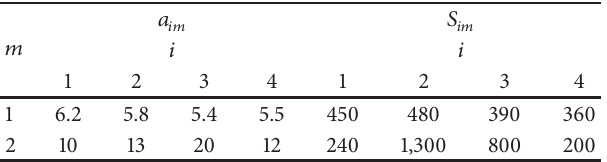
Table 2: Parameters related to different